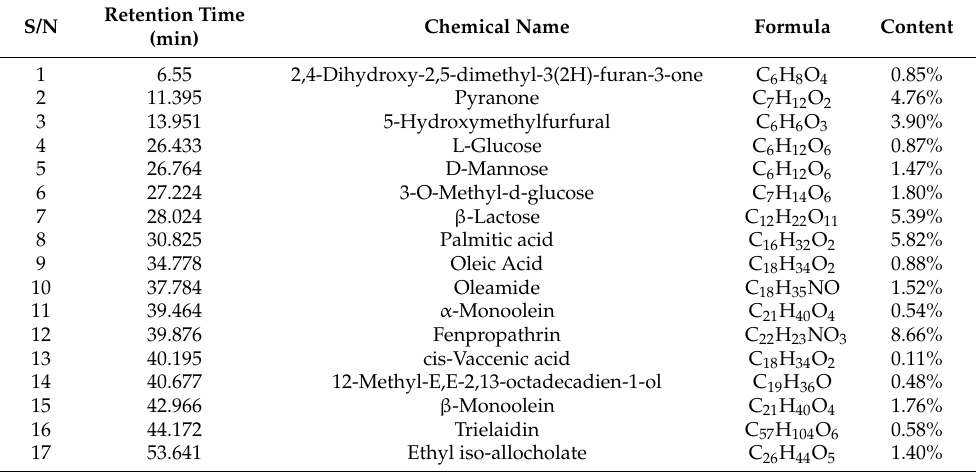
Table 1. GC-MS analysis showing the identified constituents in the methanol extracts A. hendersonii